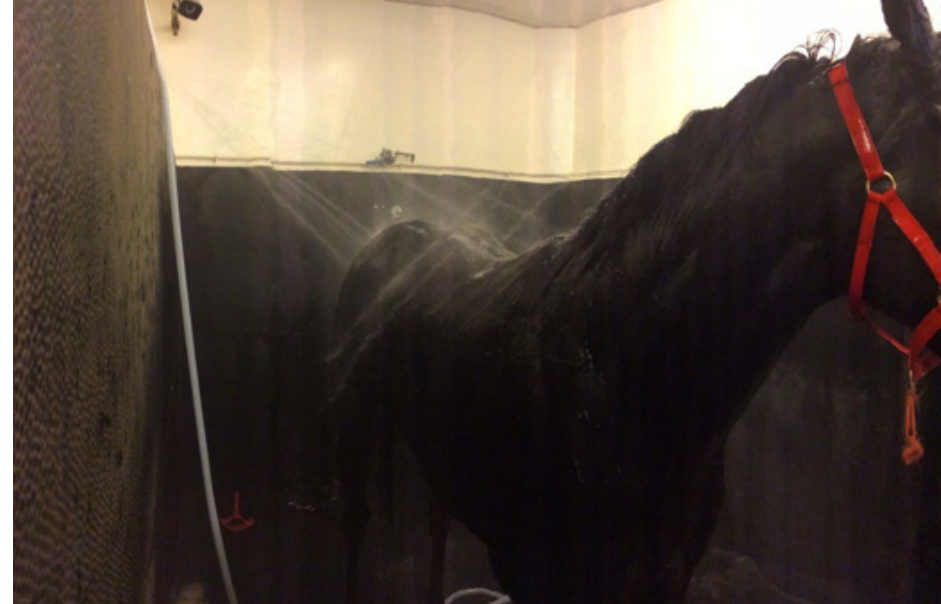
Figure 19. The dousing stall at the Hong Kong Jockey Club Sha Tin Racecourse.